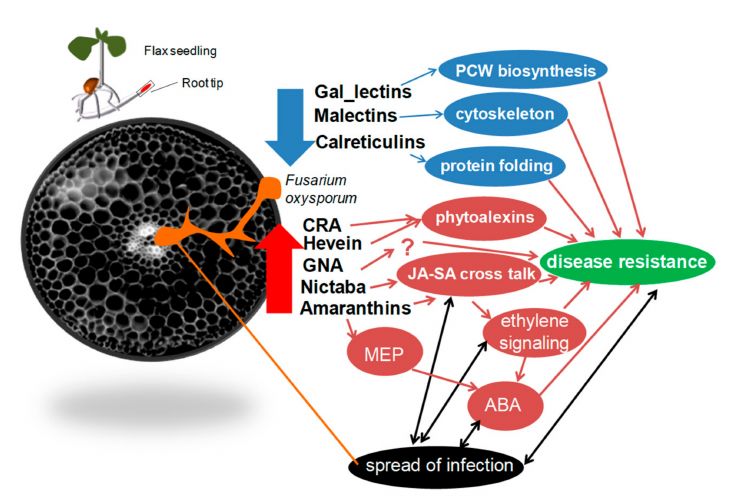
Figure 7. The hypothetical involvement of proteins with lectin domains in plant defense. The lectin gene whose expression changed drastically during the Fusarium oxysporum infection and their potential association with the general processes are presented. The downregulated and upregulated pathways are given in blue and red backgrounds, respectively. Lectins are part of a comprehensive network of plant-pathogen interactions that includes cross-talk between plant resistance and pathogen spread. SA—salicylic acid, JA—jasmonic acid, ABA—abscisic acid, MEP—non-mevalonate